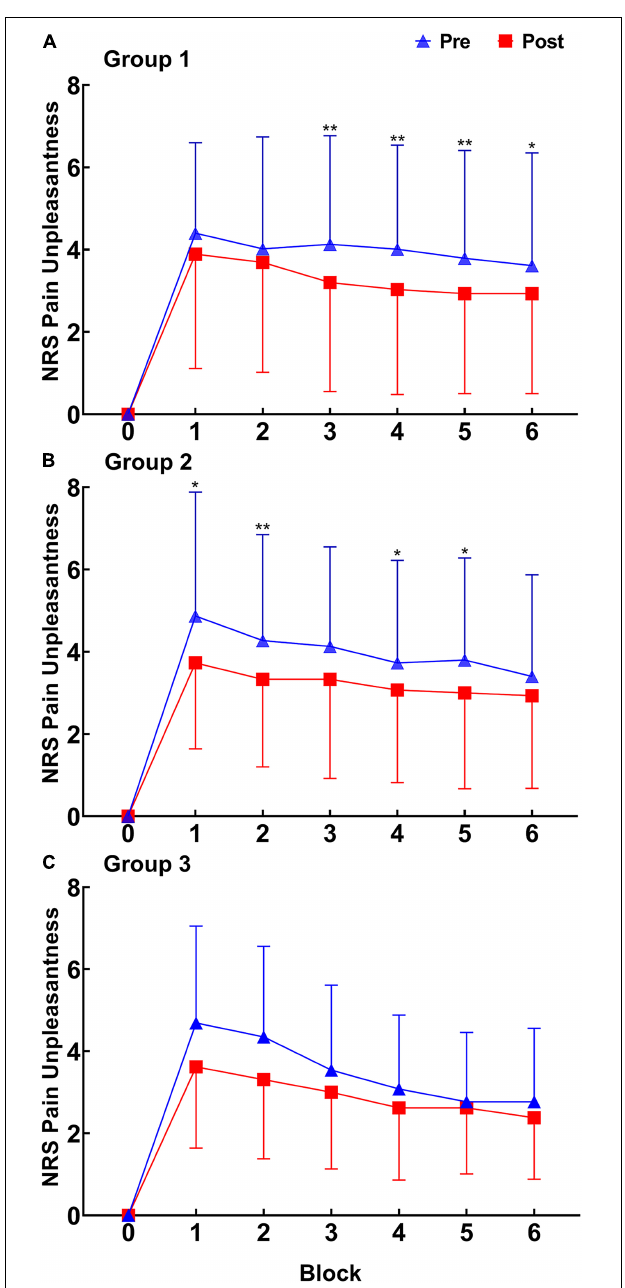
FIGURE 4 | Pain intensity ratings (X ± SD) for RPHS before and after intervention in the three groups. (A) Group 1. (B) Group 2. (C) Group 3. NRS, numeric rating scales; Pre, pretest; Post posttest. * p < 0.05; ** p < 0.01.